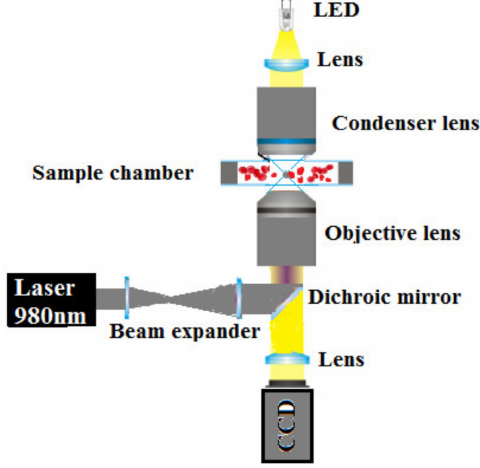
Figure 1. Scheme of the experimental setup.